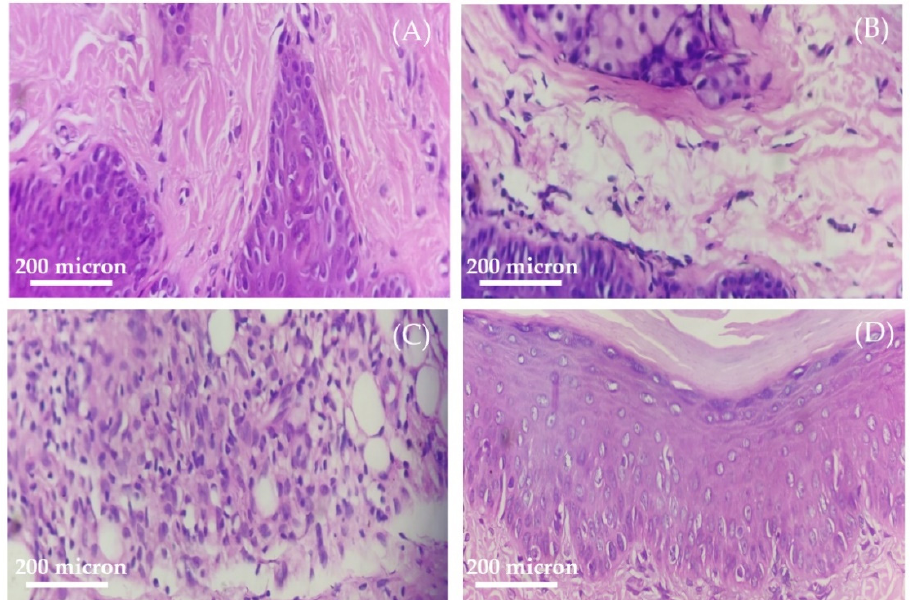
Figure 9. Histopathology of the right paw tissues of ( A ) normal control rats; ( B ) arthritic rats; ( C ) silver nanoparticle-treated rats; and ( D ) methotrexate-treated